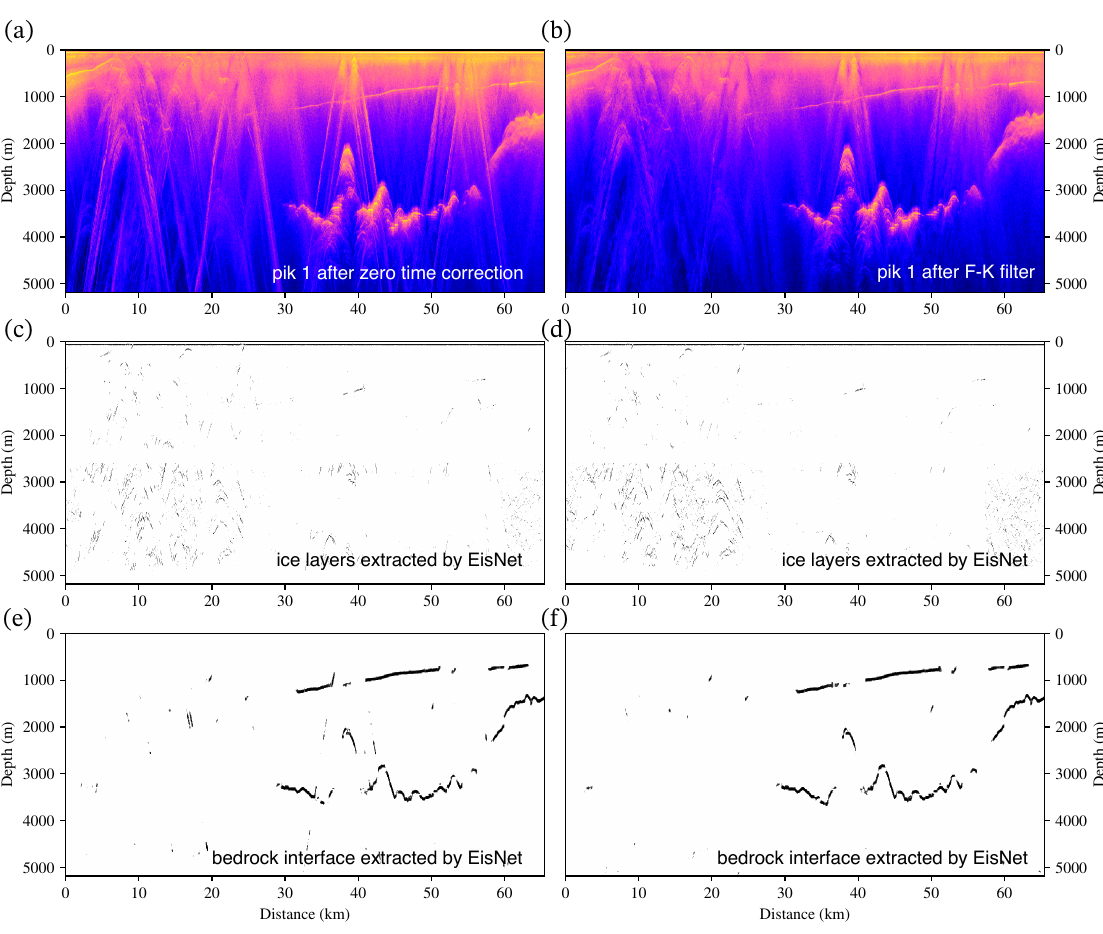
Figure 6. Comparison of EisNet extractions before and after F–K filtering from Line 2 (AMY data). ( a ) The raw input radar image. ( b ) The input radar image after F–K filtering as a preprocess. ( c ) The extracted feature of internal layers without F–K filtering. ( d ) The extracted feature of internal layers from the radar image after F–K filtering as a preprocess. ( e ) The extracted feature of the bedrock without F–K filtering. ( f ) The extracted feature of the bedrock from the radar image after F–K filtering as a